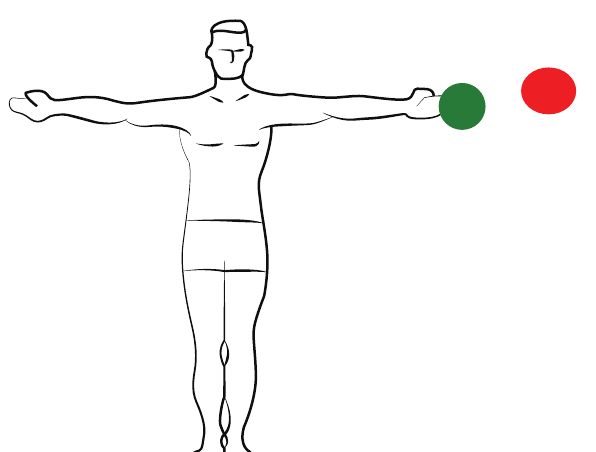
Figure 2: The user is within normal reach of the green object but must change the centre of mass to reach and grab the red